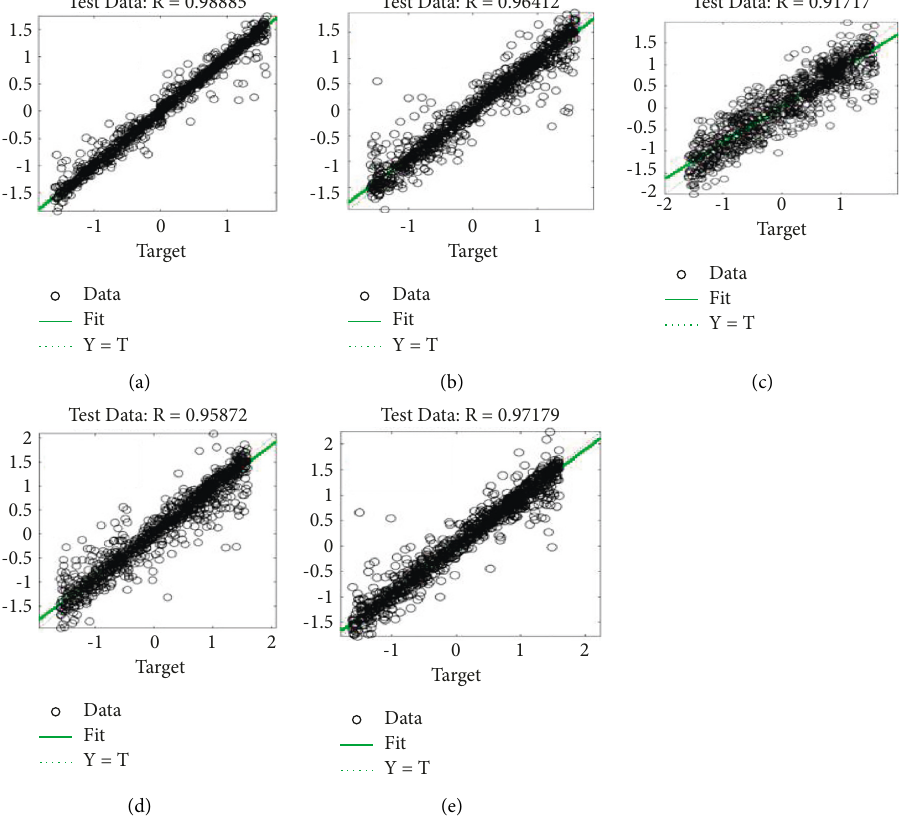
Figure 9: Best correlation results between predicted and measured values. (a) SCM-ANFIS for joint 1; (b) GP-ANFIS for joint 2; (c) GP- ANFIS for joint 3; (d) GP-ANFIS for joint 4; (e) GP-ANFIS for joint